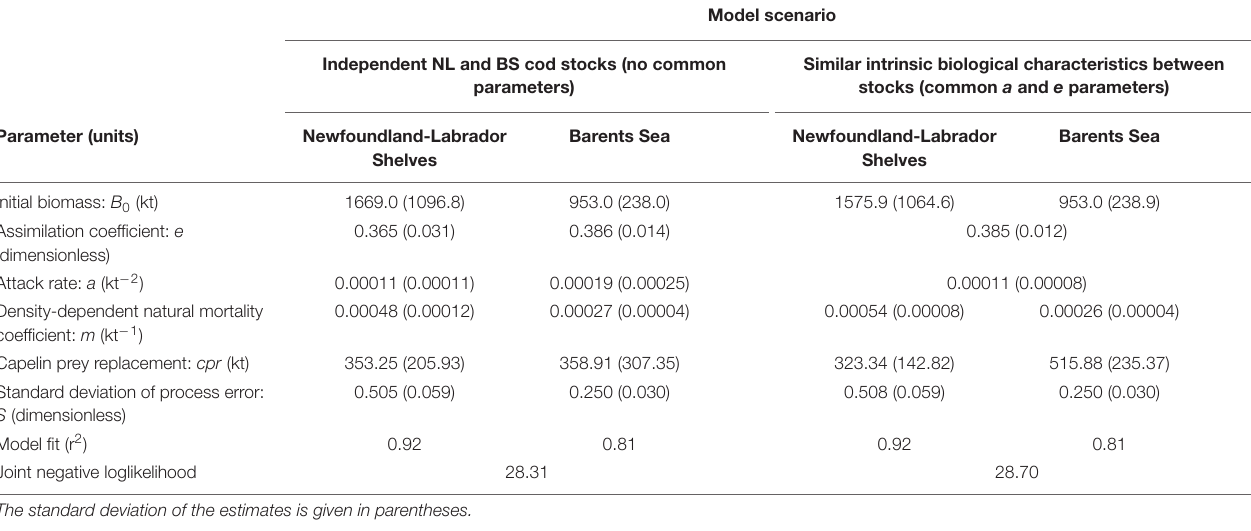
TABLE 1 | Estimated parameters and goodness of fit for the general integrated model, assuming fully independent NL and BS cod stocks (no common parameters between stocks), and the restricted model assuming similar intrinsic biological traits between stocks (common a and e parameters).